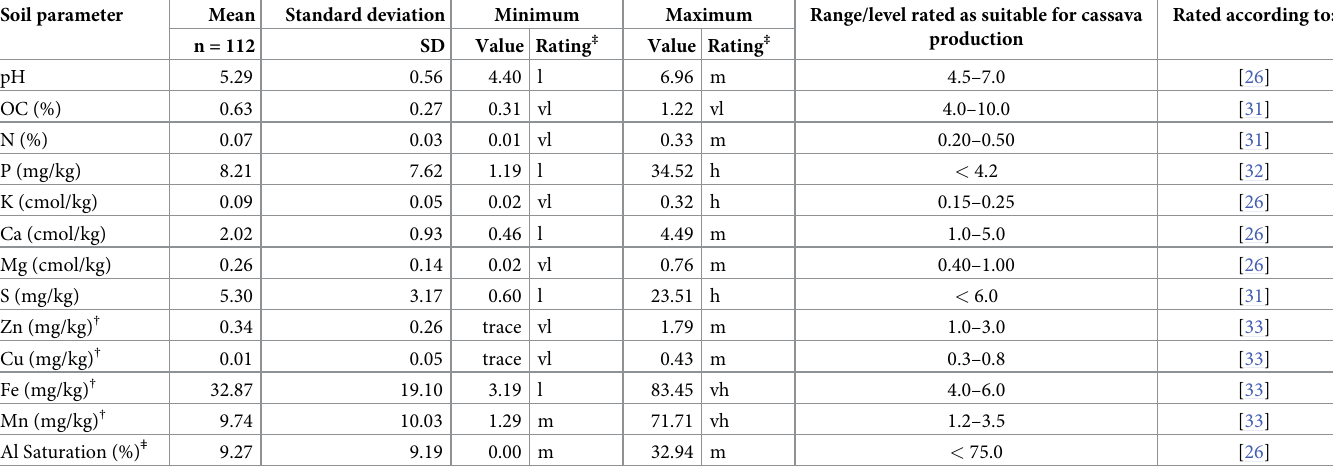
Table 2. Soil chemical characteristics of crop fields located in konzo-affected villages of Mtwara region and their suitability for cassava production. Soil